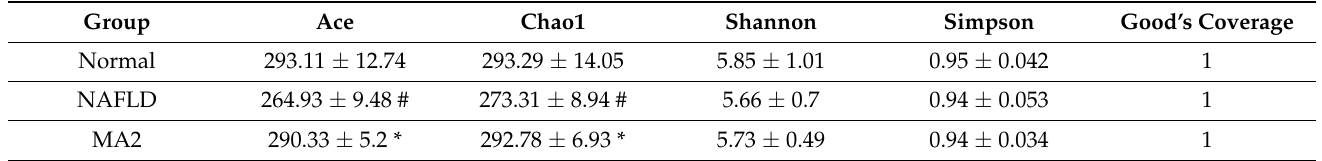
Table 2. α Diversity index in different group of rats.